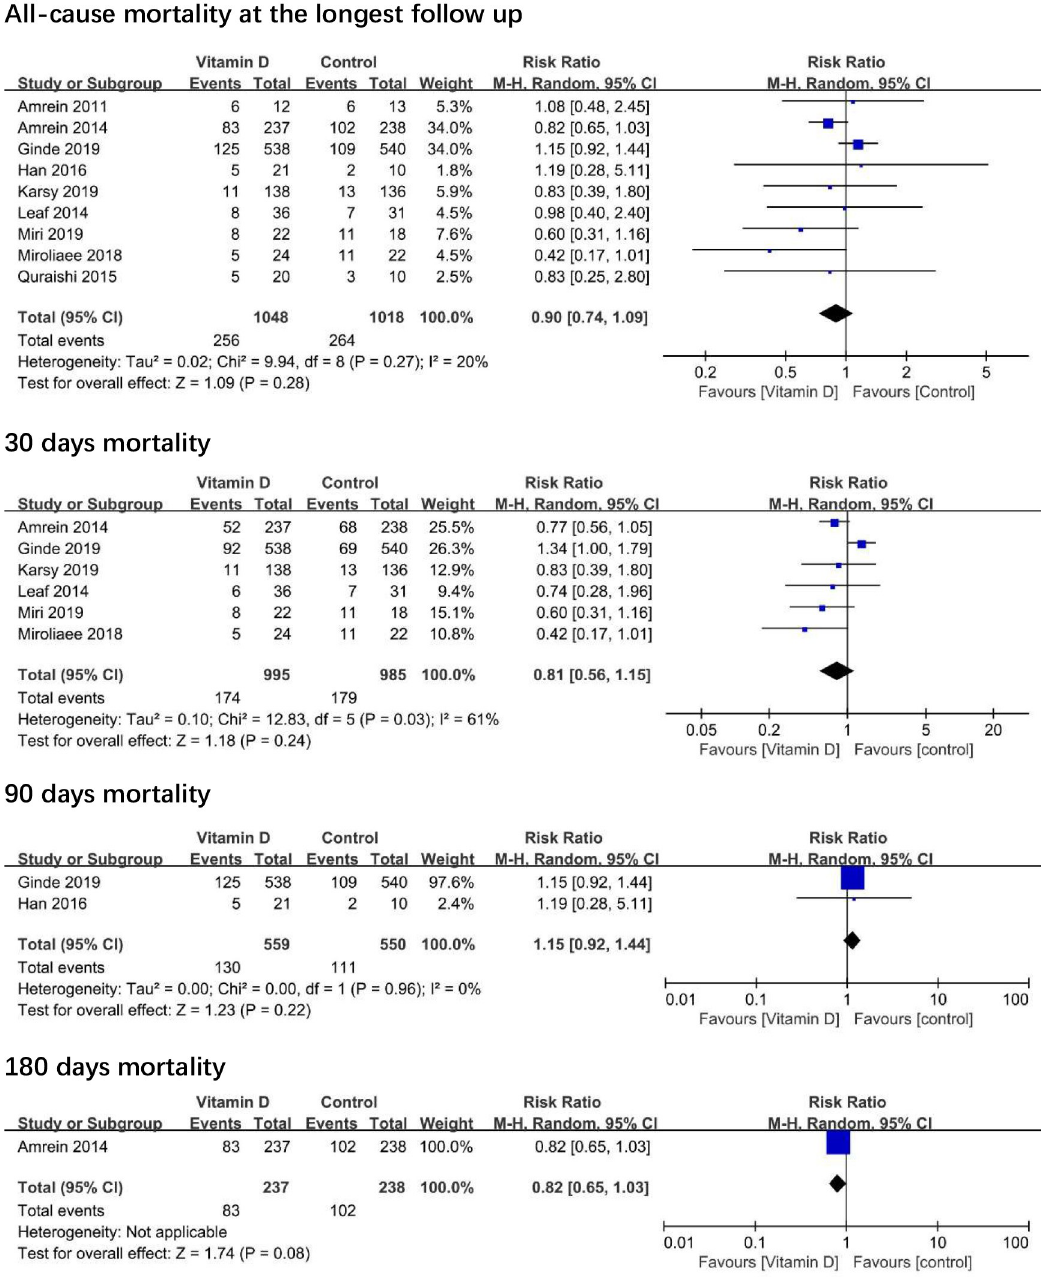
Fig 2. Association of vitamin D versus placebo with